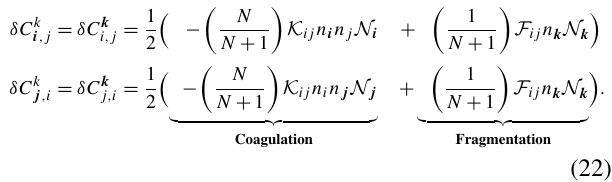
Figure 3. Example of a complete set of reactions applied to N = 4 size bins, with an additional class 3 vectors are shown on top with the four size bins defined by the size range, and the last one representing the size bin 3 are modified versions of (a) T + B + 2 D (Eq. 14) and (b) F (Eq. 15). Coloured areas and arrows indicate an exchange with the concentration vector. Solid and dashed arrows indicate coagulation and fragmentation reactions,